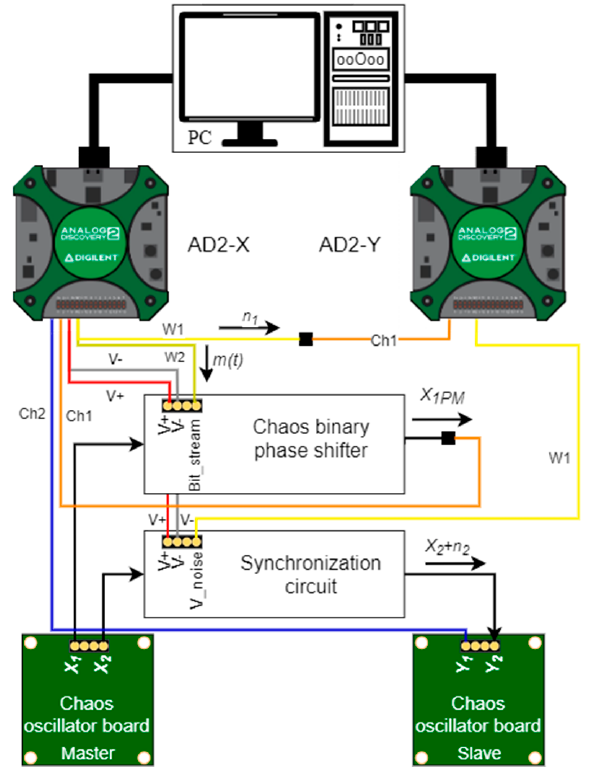
Figure 10. Hardware model of the proposed communication system’s experimental study in the AWGN propagation channel.